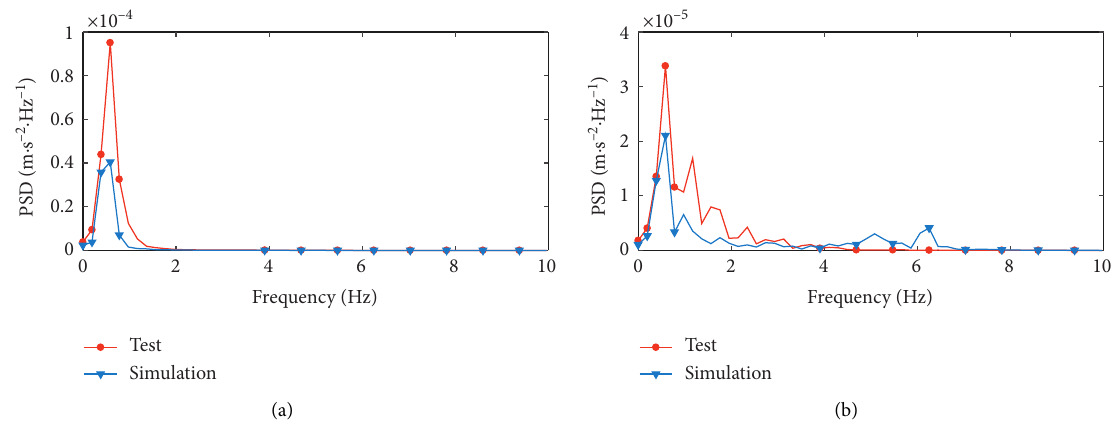
Figure 7: Comparison of vibration acceleration between simulation and test. (a) Car body. (b) Bogie.